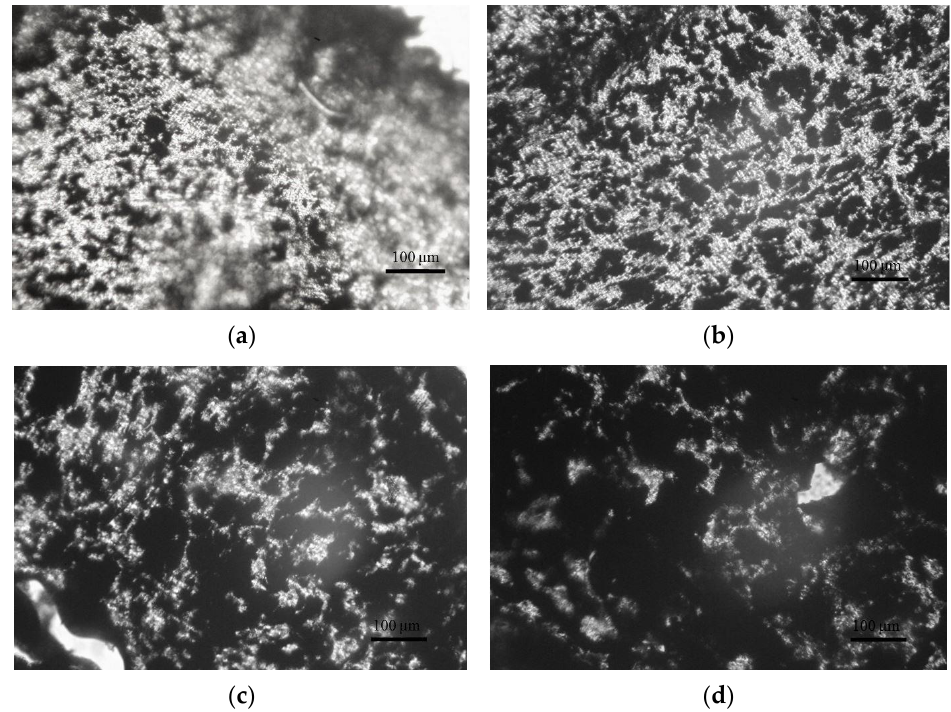
Figure 6. Optical images of the transversal cross-sections of the filaments PLA + 1 vol.% CB ( a ), PLA + 2.5 vol.% CВ ( b ), PLA + 5 vol.% CВ ( c ), PLA + 7 vol.% CВ ( d ).